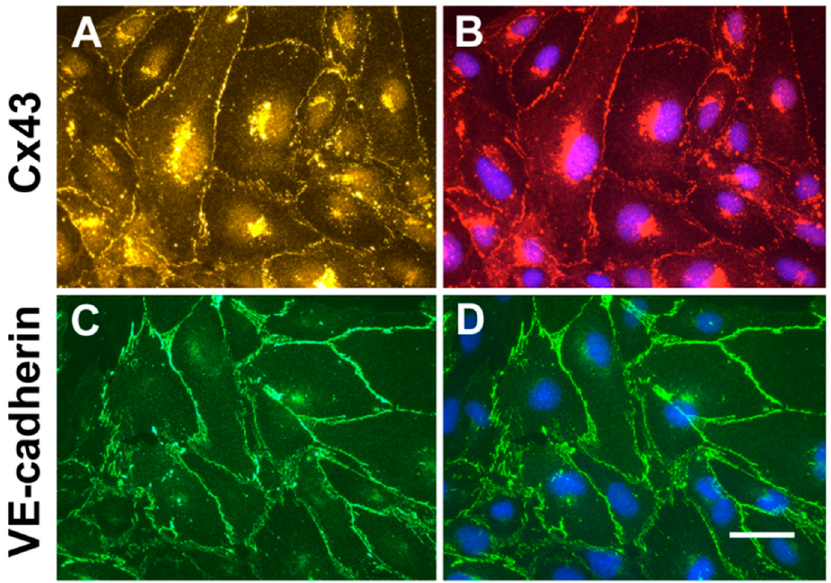
Figure 1. Microvascular endothelial cells have intercellular junctions containing Cx43 and VE-cadherin. ( A , B ) Immunolocalization of Cx43 (yellow in A , red in B ). ( C , D ) Immunolocalization of VE-cadherin (green). Panels B and D were also stained with DAPI to visualize nuclei (blue). Bar, 10 µm.